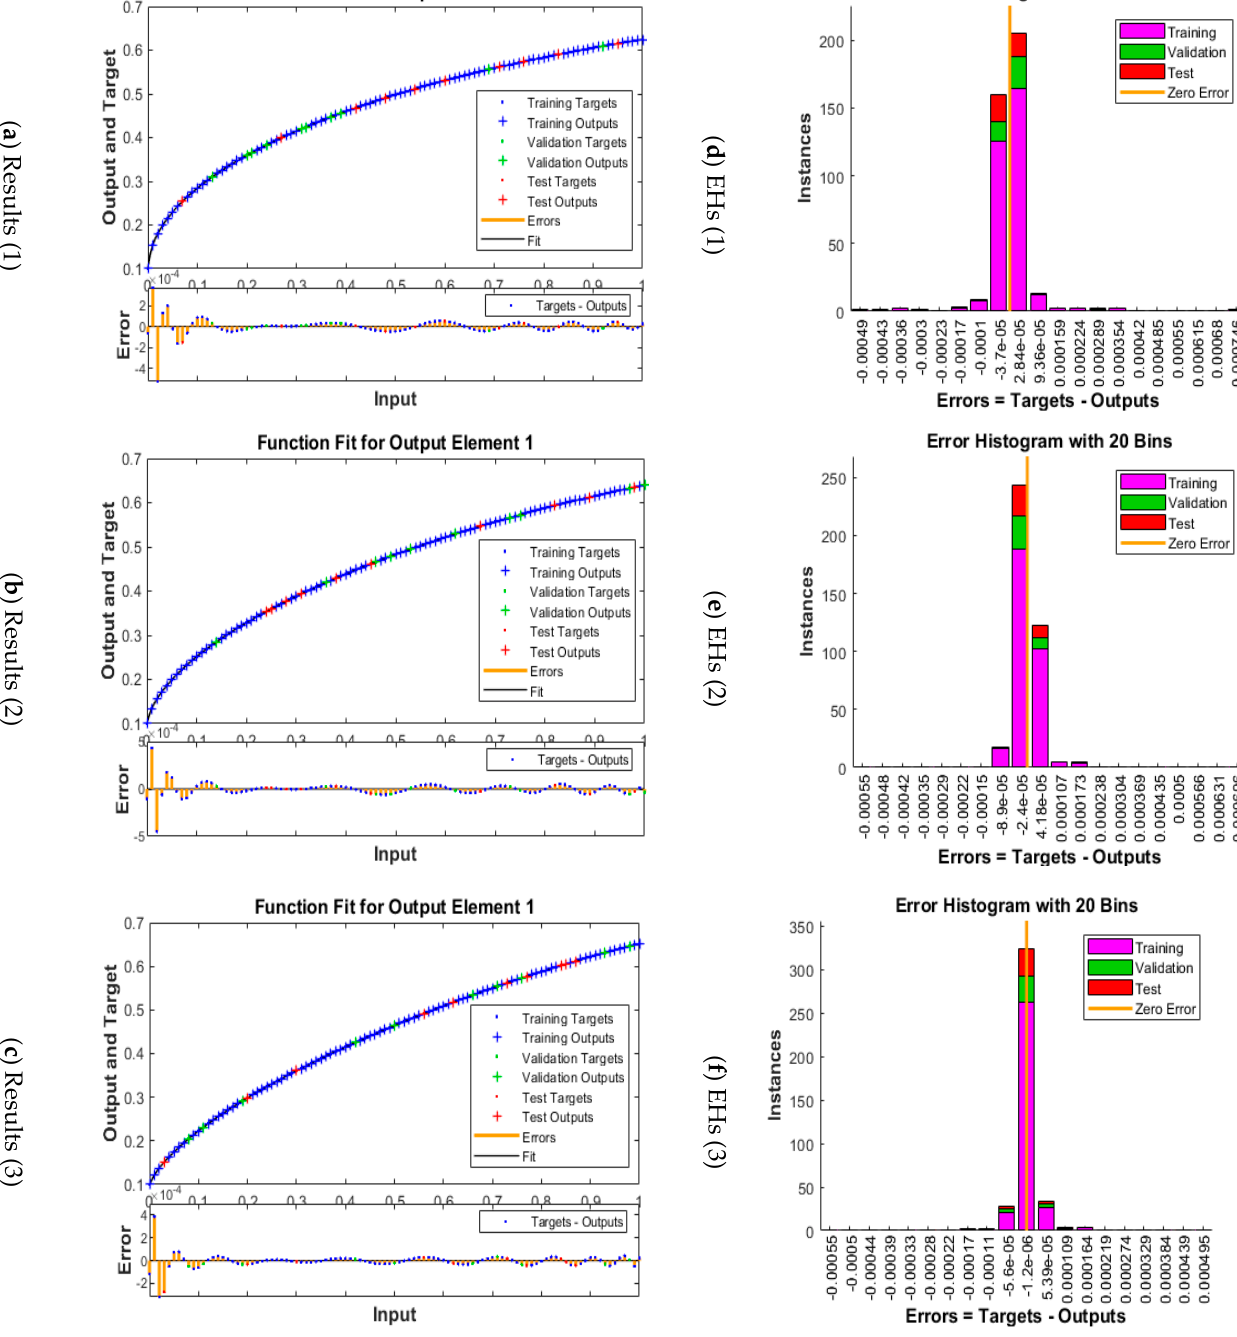
Figure 4. Assessments of the outcomes along with the EHs to solve the FO-MML love story model.